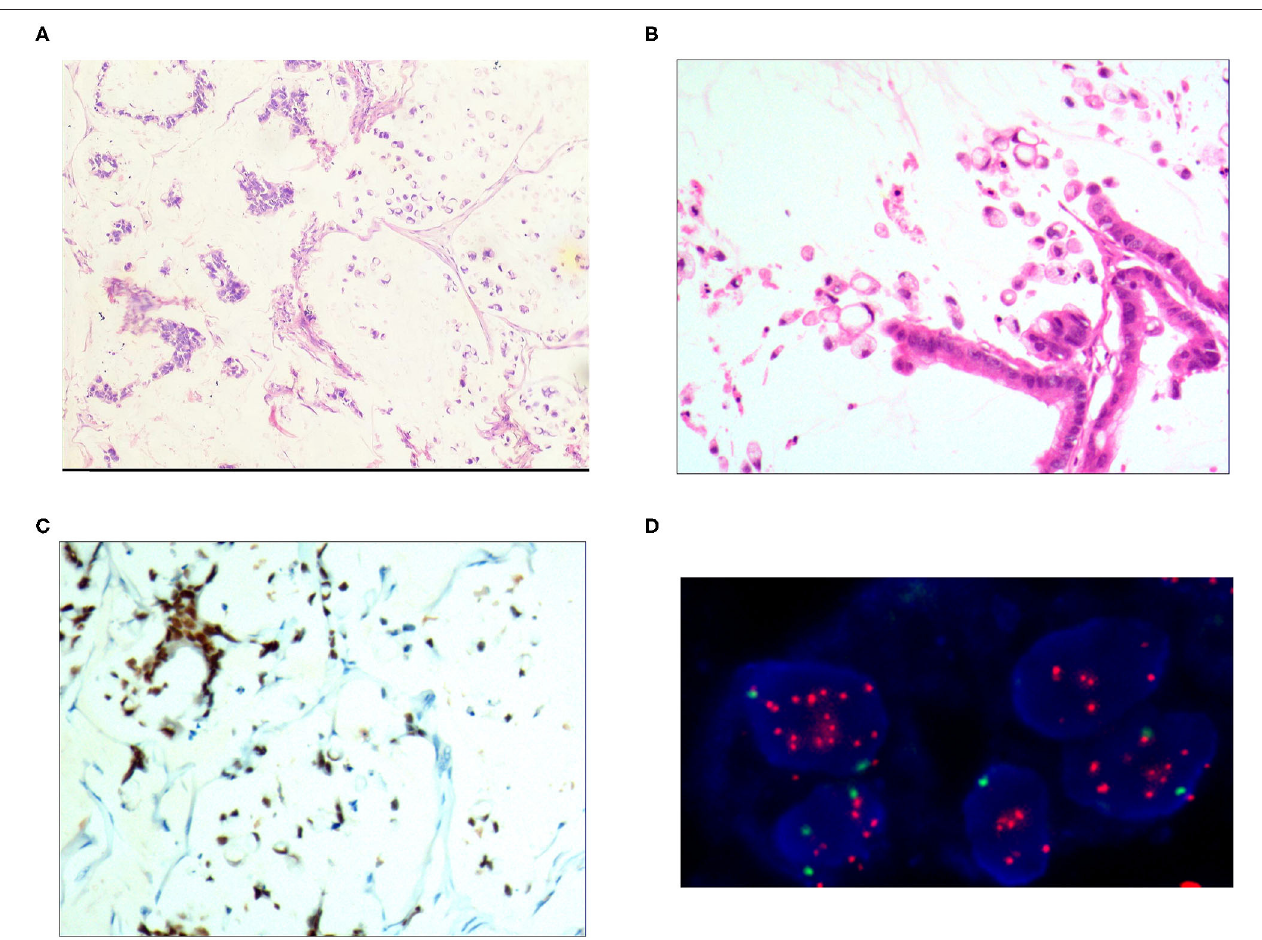
FIGURE 4 | Mixed cell type mucinous carcinoma. (A) It was composed of cells of differentiated tubular and papillary adenocarcinoma and signet ring cell carcinoma and large areas of mucinous tissues; H&E, × 100. (B) The differentiated adenocarcinoma had a columnar shape, and the signet ring cell carcinoma cells had a typical signet ring structure; H&E, × 200. (C) CDX2 was positively expressed in the differentiated adenocarcinoma and signet ring cell carcinoma cells; EnVision TM method, × 100. (D) The HER2 gene was amplified in a dot shape; red stands for the probe signal, and green stands for chromosome 17. The FISH method was used